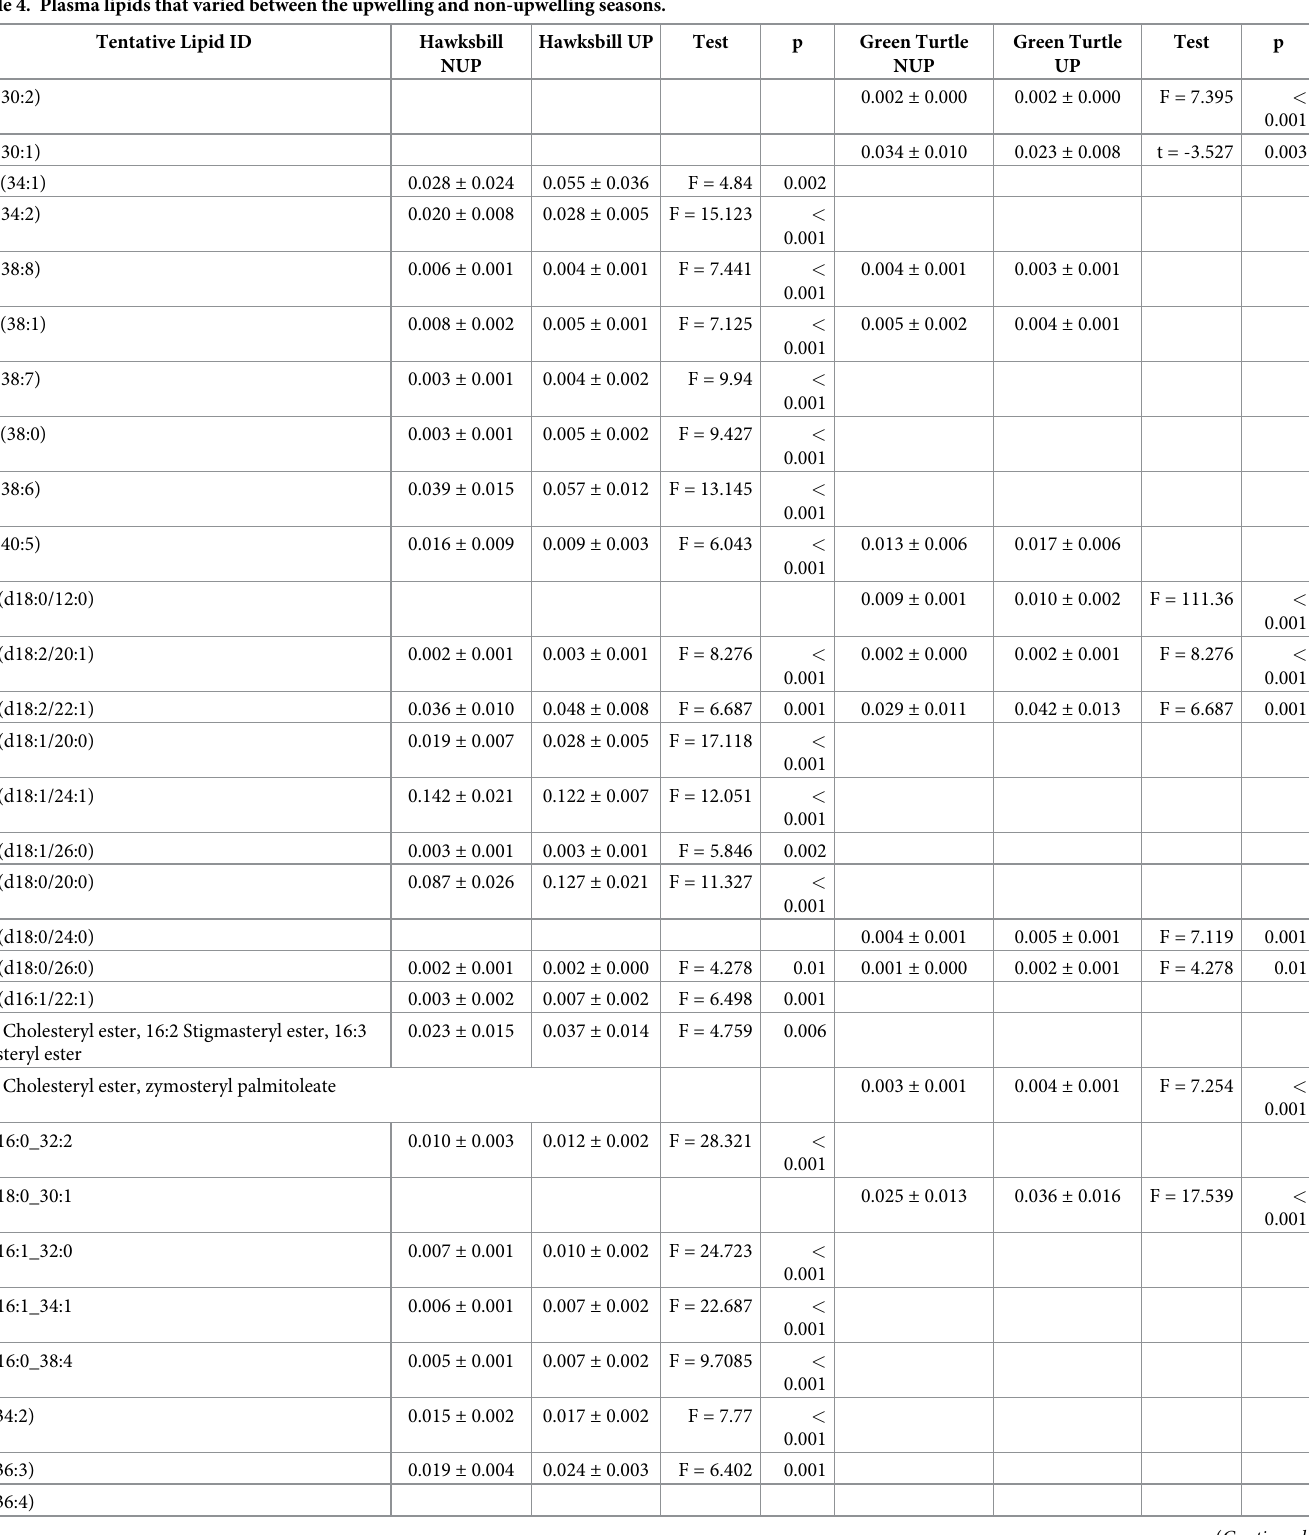
Table 4. Plasma lipids that varied between the upwelling and non-upwelling seasons. Tentative Lipid